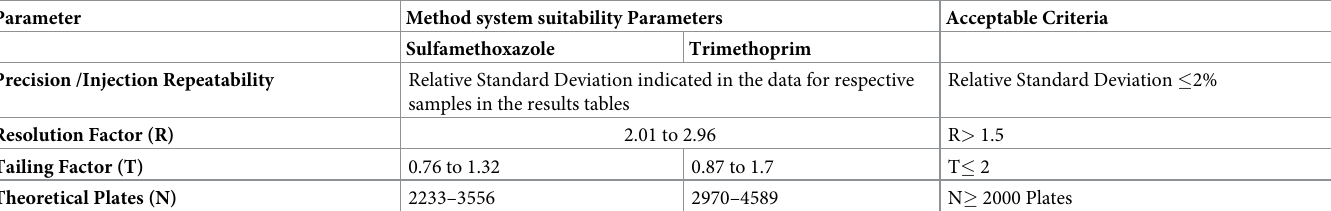
Table 1. Method suitability